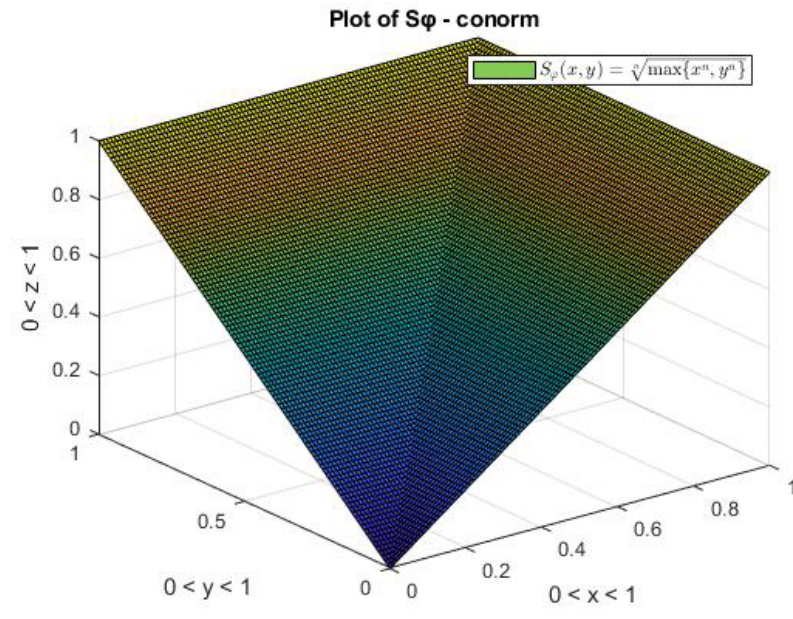
Figure 4. S-conorm generated from S M using an automorphism function.